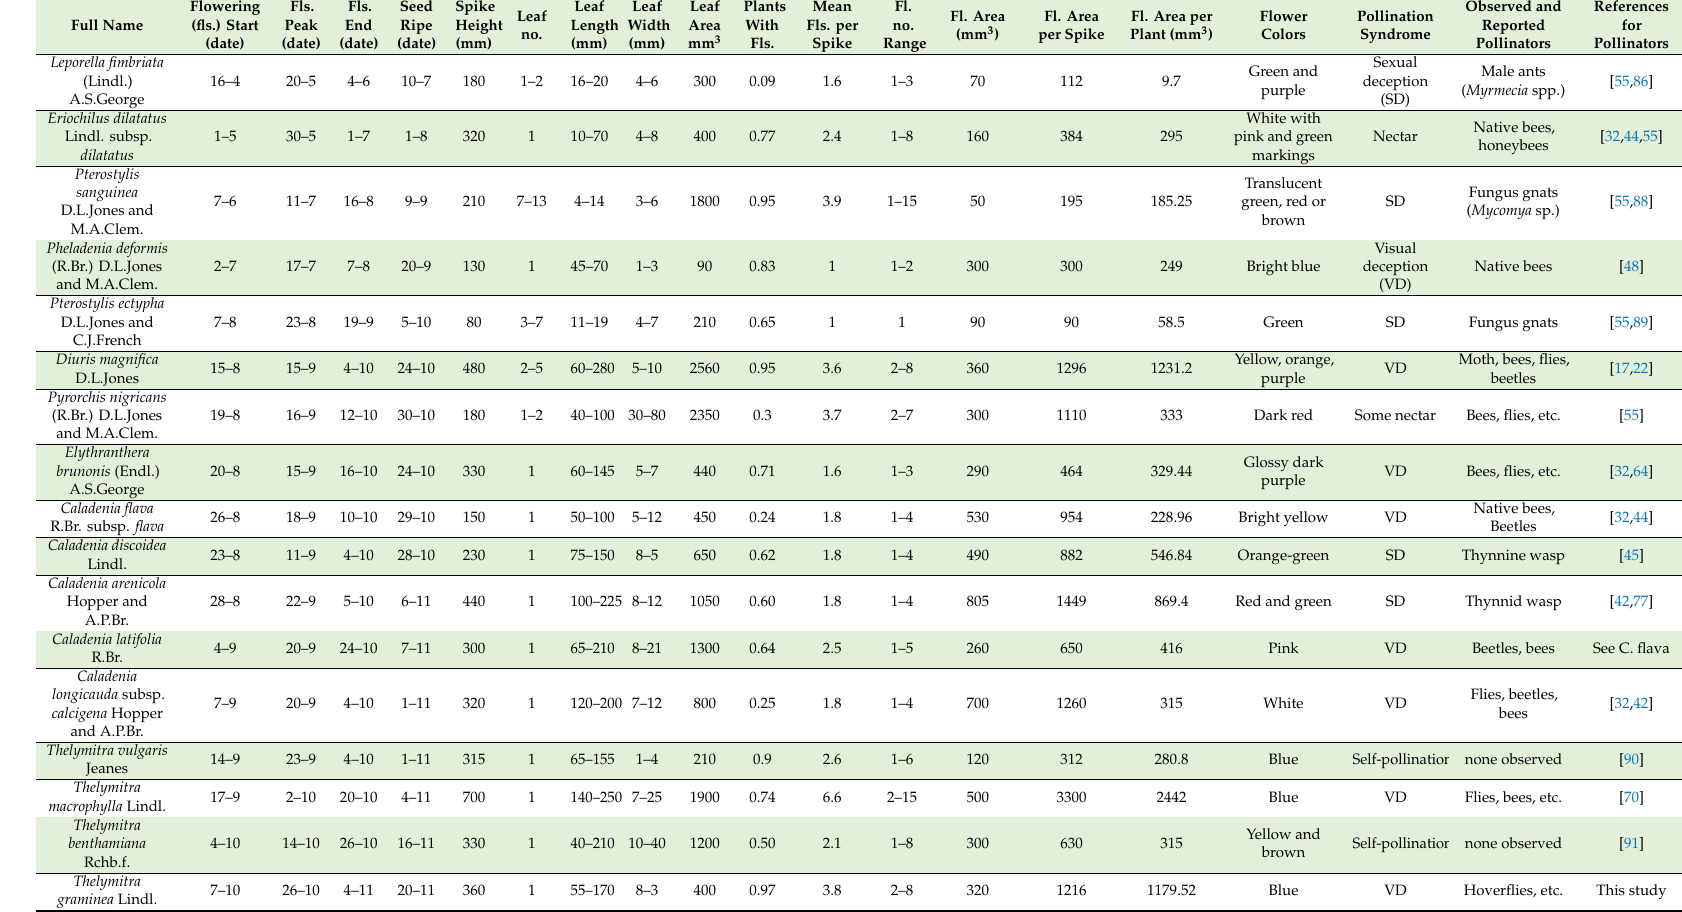
Table A1. Summary of measured attributes of species in this study for flowering chronology and e ff ort (see methods), along with observed pollinators